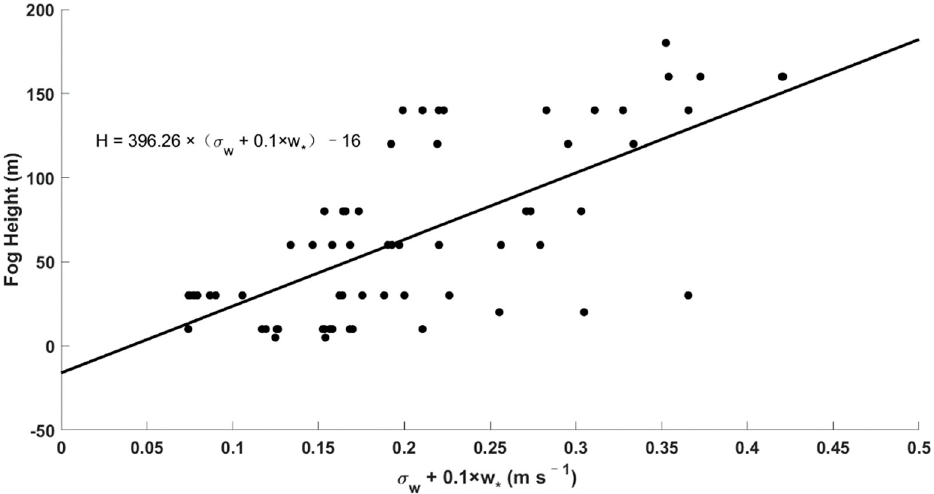
Figure 5. Scatterplots of observations of fog-top height against the variance of vertical velocity and the new w * . The solid line denotes the relationship H = 396.26 × ( σ w + 0.1 × w * ) – 16.